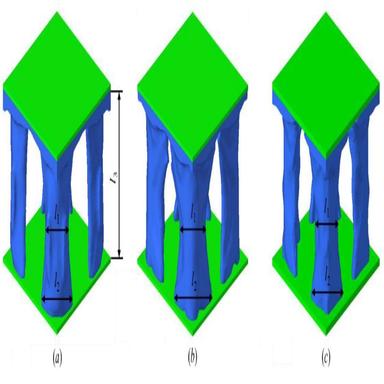
Topology optimisation results derived from various cell-wall materials: (a) HSSG350; (b) AA6063; (c) Ti6Al4V.